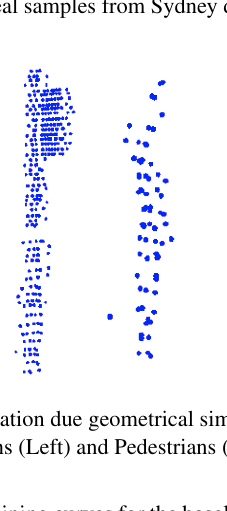
Figure 2. Confusion Matrix for the baseline model trained and tested on real samples from Sydney dataset